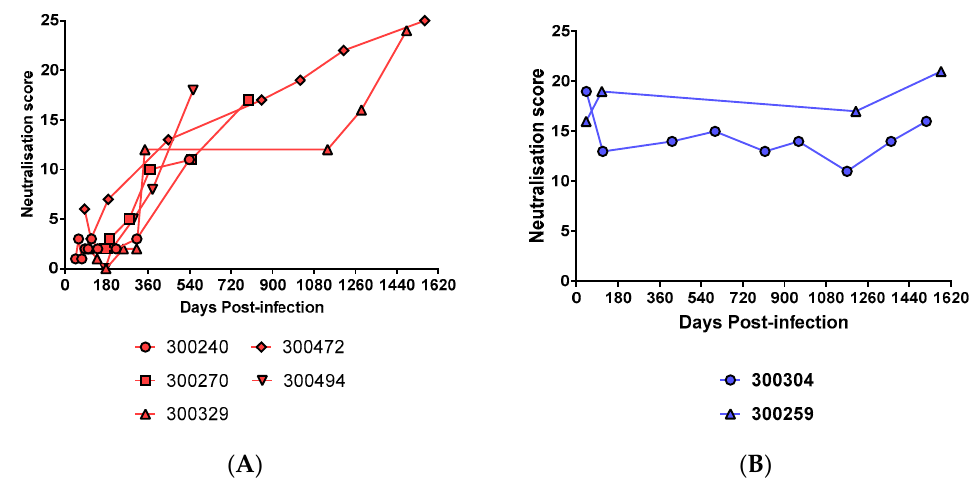
Figure 6. Neutralisation scores analysed longitudinally in persistent ( A ) mono-infections and ( B ) incident mixed infections. Neutralisation scores in mono-infections increased with the duration of the infection. These scores did not reach a comparable level to incident mixed infections until 700 days post-infection. In incident mixed infections, neutralisation scores developed earlier than mono-infections but did not increase with persistent viraemia.